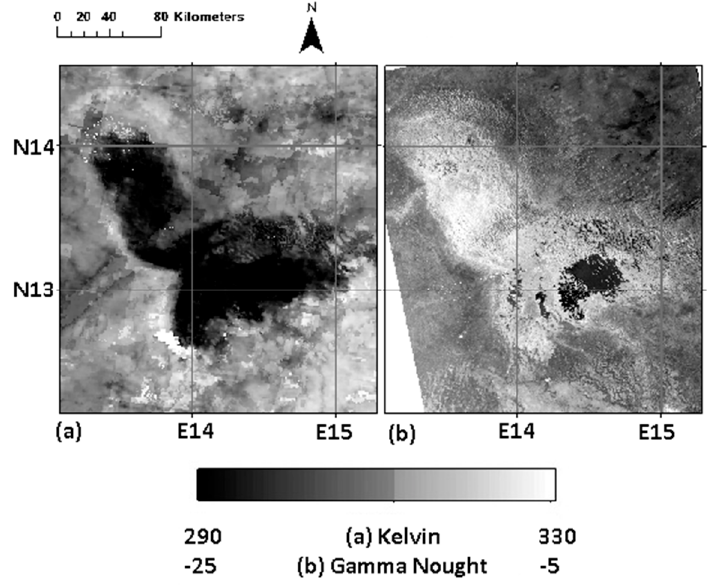
Figure 2. Examples of the remote sensing products used in this research ( a ) NASAMODIS Land Surface Temperature (LST) (9 May 2017–16 May 2017); ( b ) ESA Sentinel-1a C-band Radar (16 May 2017).